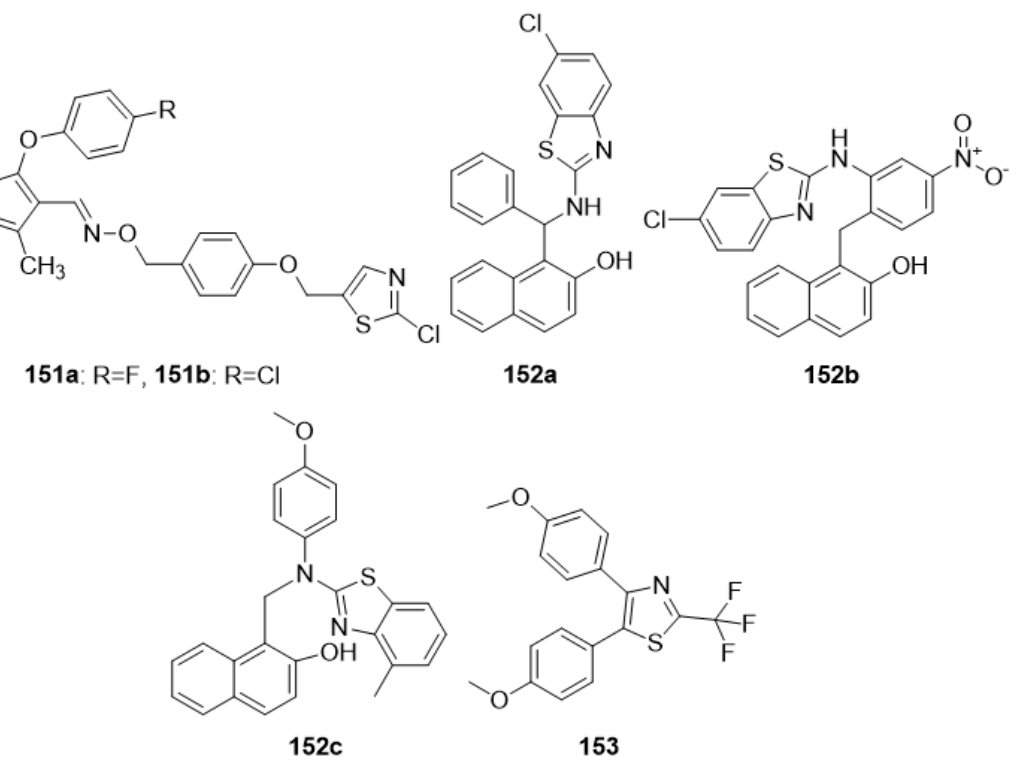
Figure 13. Recently designed and synthesized thiazoles as potential other bioactive agents.